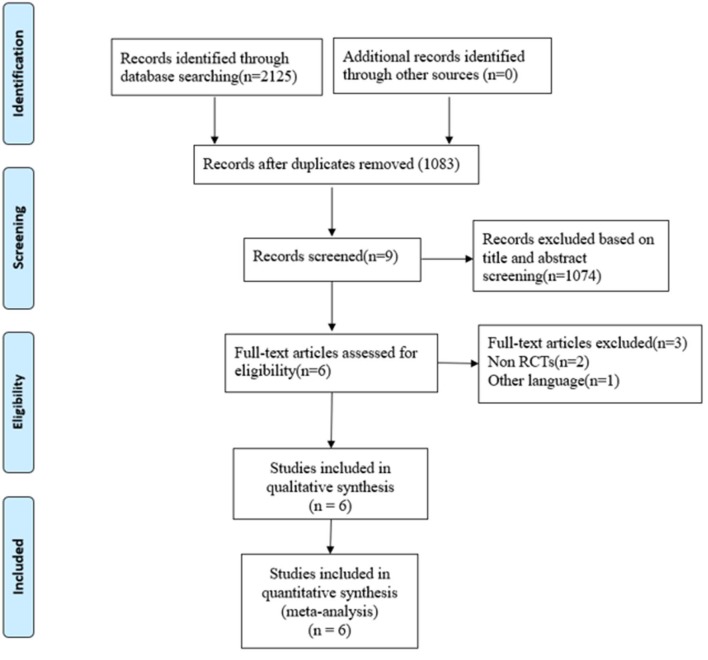
Flowchart of study selection.